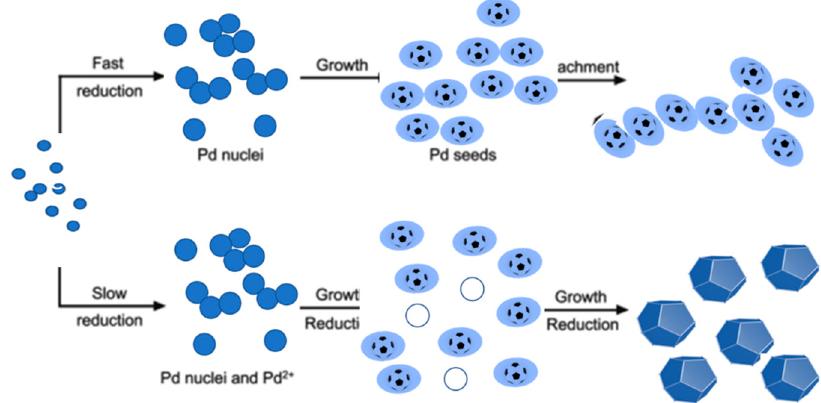
Figure 17. Schematic illustration of the effect of reaction kinetics affects the nucleation, growth, and final morphology of Pd nanostructures in a polyol synthesis.